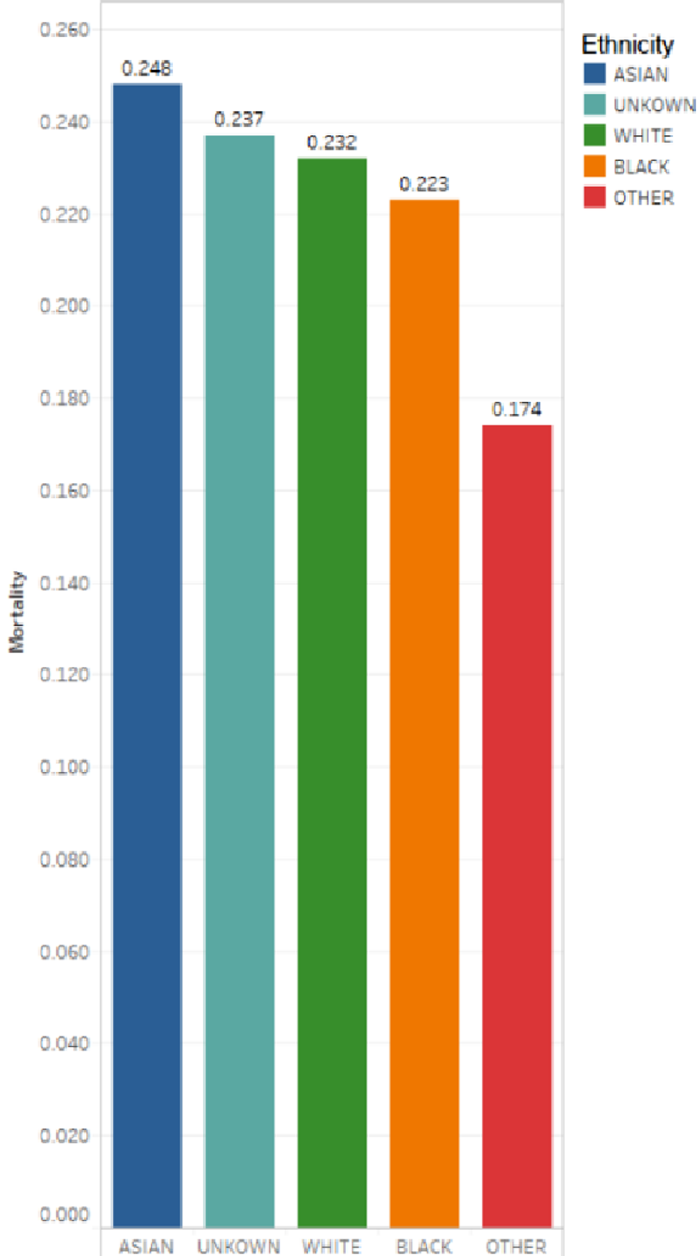
Fig 3. Mortality of different race (It is calculated as: The number of deaths per race/the total number of patients per race).